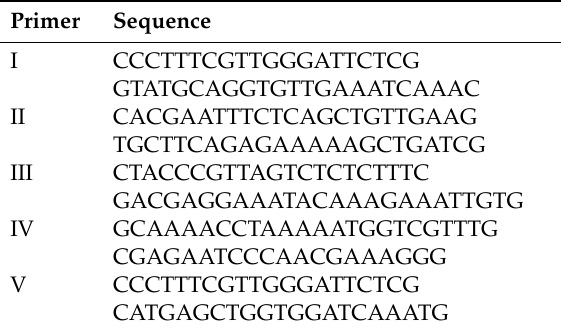
Table A2. Primers used to identify At PARN splice